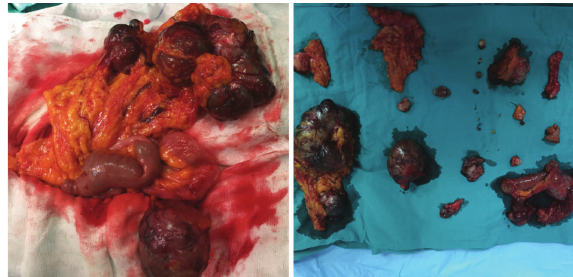
Figure 1: Peroperative and postresection images of the lesions.